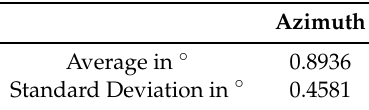
Table 11. Azimuth measurements.